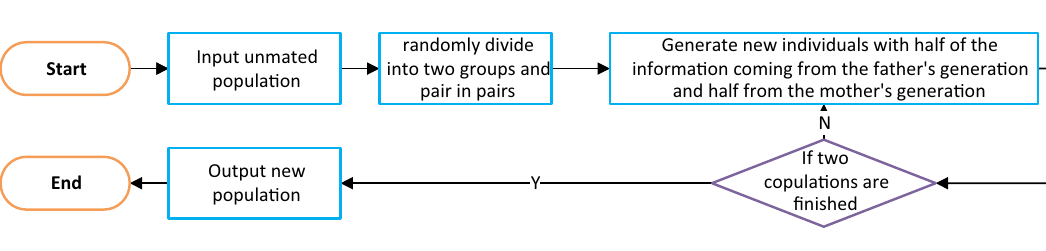
Figure 20. Flowchart of offspring generation in genetic